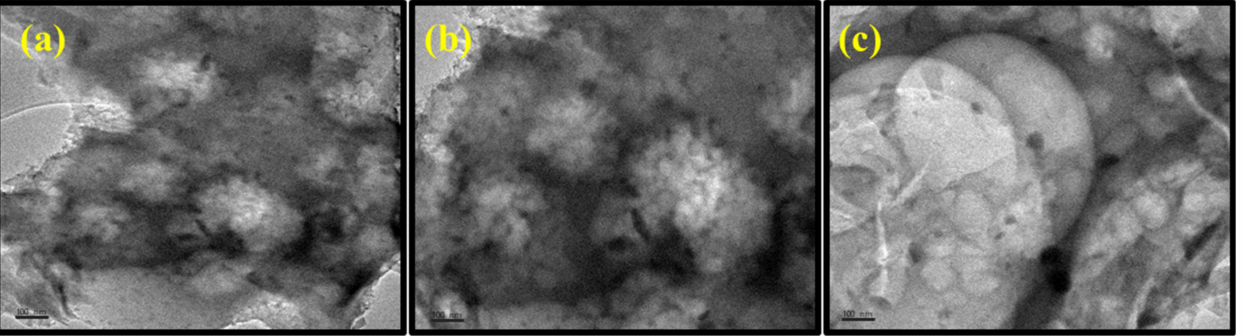
Figure 4. TEM images of ( a ) NRPC-700, ( b ) NRPC-800 and ( c ) NRPC-900. The activated porous carbon materials derived from polybenzoxazines contain rela- tively higher content of nitrogen species about 3.64–6.26 wt.% and oxygen species about 10.61–13.65 wt.%. The presence of these heteroatoms (N and O atoms) effectively